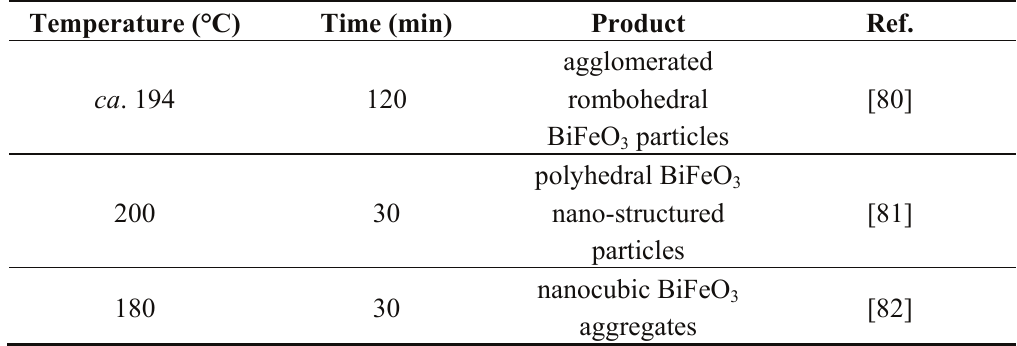
Table 2. Comparison of three different microwave-assisted hydrothermal synthesis strategies proposed for the obtainment of single BiFeO